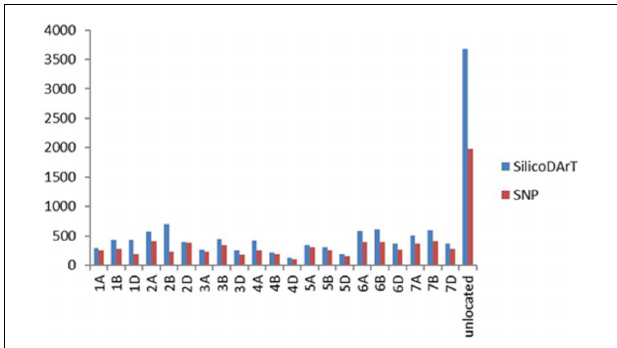
FIGURE 2 | The distribution of SilicoDArT and SNP markers according to their chromosome location provided by DArT P/L, Australia.